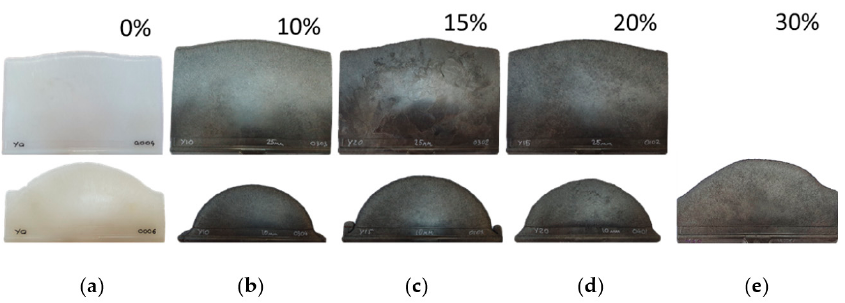
Figure 4. Experimentally obtained plate melt front at molding composites with different fiber mass fraction: ( a ) 0%; ( b ) 10%; ( c ) 15%; ( d ) 20%; ( e ) 30%.